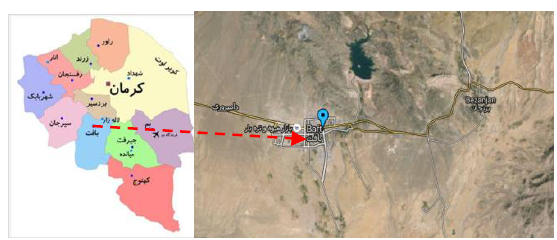
Figure 1. Geographical location of the study